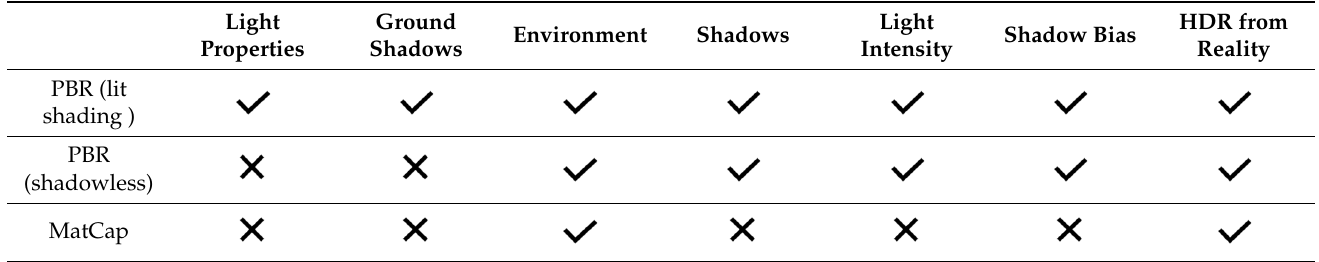
Table 7. Lighting modifier analysis.